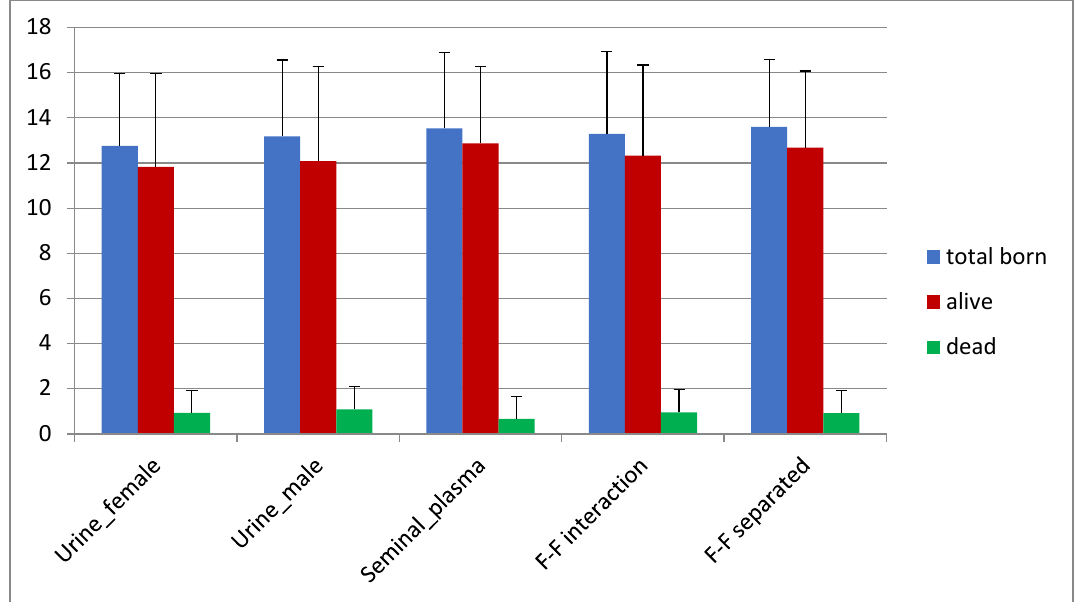
Figure 3. Prolificacy rate (number of born alive / dead animals) in each of the different experi- mental groups.